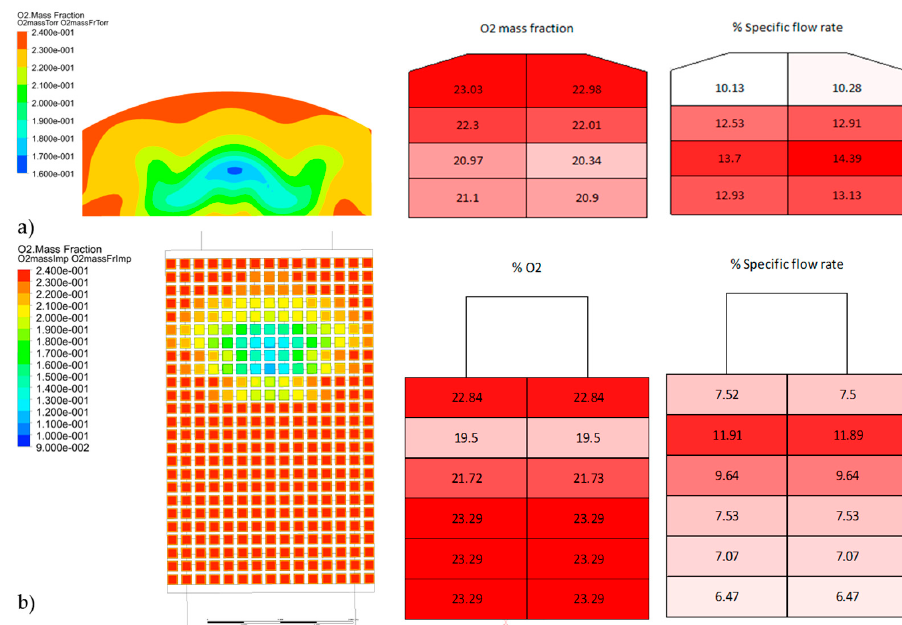
Figure 12. O 2 mass fraction and specific flow rate for 10% WGR—( a ) port neck section ( b ) checkers section.